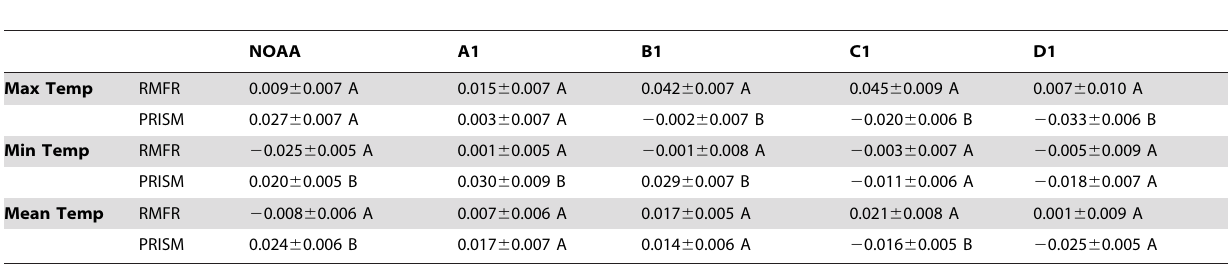
Table 4. Direction and rates of change in max, min and mean temperature ( 6 SD) over the past 56 years projected by the RMFR climate stations and interpolated by PRISM.